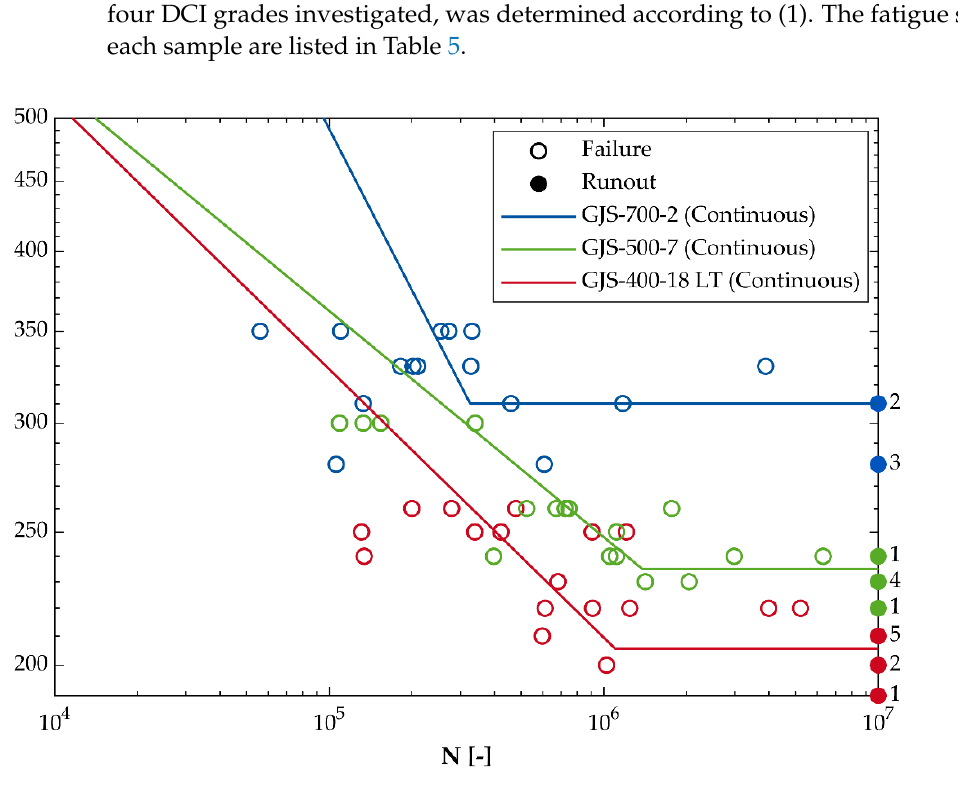
Figure 5. Results of the fatigue tests for the continuous cast grades (straight line: 50% probability of failure).